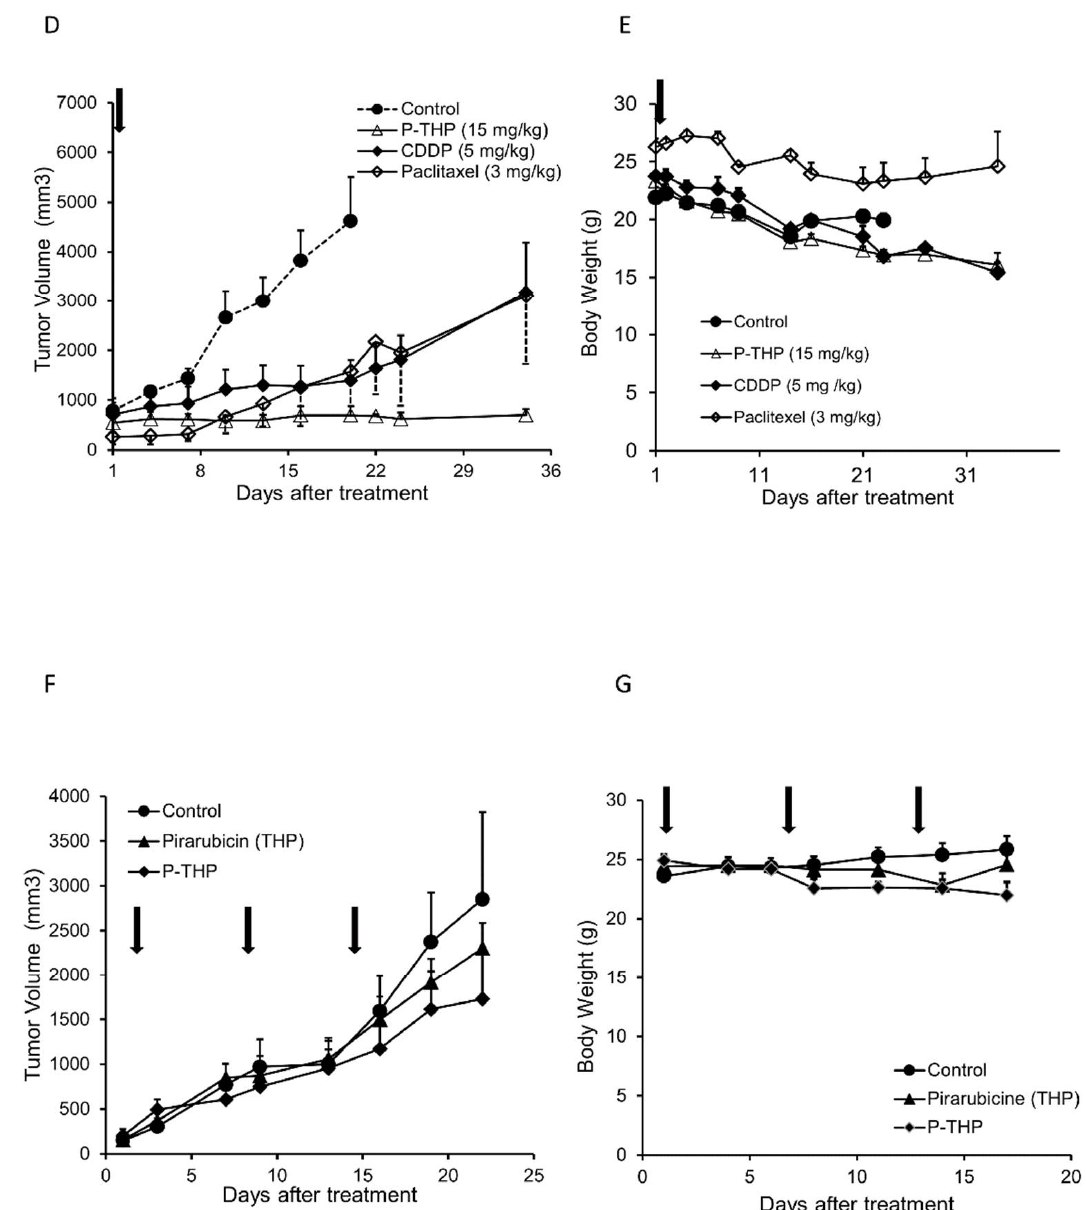
Figure 3. Antitumor effect of P-THP in vivo. MES-SA C9 high tumor-bearing mice ( A , B ): Free THP and P-THP at 5 mg/kg and 15 mg/kg of THP-equivalent doses are weekly administered three times from the tail vein when the tumor diameter is 6–12 mm. ( A ) Tumor volume (mm 3 ) and ( B ) body weight (g) change. Data ± SEM ( n = 4). MES-SA C9 high tumor-bearing mice ( C ): ( C ) Tumor weight after 36 days of treatment started of sacrifice mice revealed P-THP was significantly less than THP, as well as fluorescence imaging. Fluorescence images showed mice tumors treated with THP or P-THP. The tumors were cut in the middle of tumor nodules, and the cross-sectional views were shown. Data ± SEM ( n = 4). A2780cis tumor model ( D , E ) of 1.5 × 10 7 cells per inoculation were in- jected: THP and P-THP at 5 mg/kg and 15 mg/kg of THP-equivalent doses were weekly adminis- tered from 6–12 mm of initial tumor size ( n = 3). Data are expressed as Data ± SEM. Paclitaxel (3 mg/kg) was used with 4 weekly i.v. injections. A2780/ADR tumor model ( F , G ) of 1.5 × 10 7 cells per inoculation: THP and P-THP at 5 mg/kg and 15 mg/kg of THP equivalent doses were weekly ad- ministered from 4–10 mm of initial tumor size ( n = 4). Data± SEM ( n = 4). Regarding the dosing of P- THP, 3 injections were carried out only in the A2780/ADR tumor model; for the other tumor model, one injection of P-THP was performed. 4. Discussion The anticancer activity of P-THP has been reported in various types of tumor cell lines, including cervical cancer (HeLa cells), melanoma (B16-F10), colon cancer